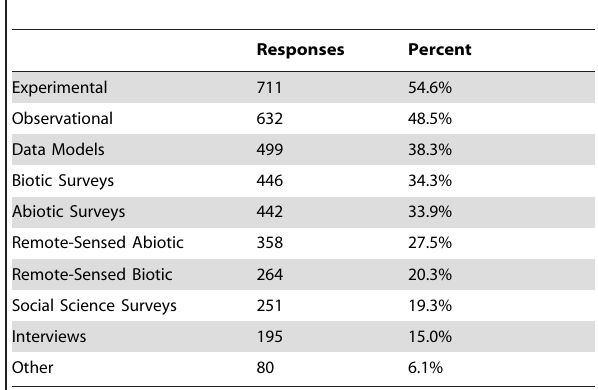
Table 2. Subject discipline.